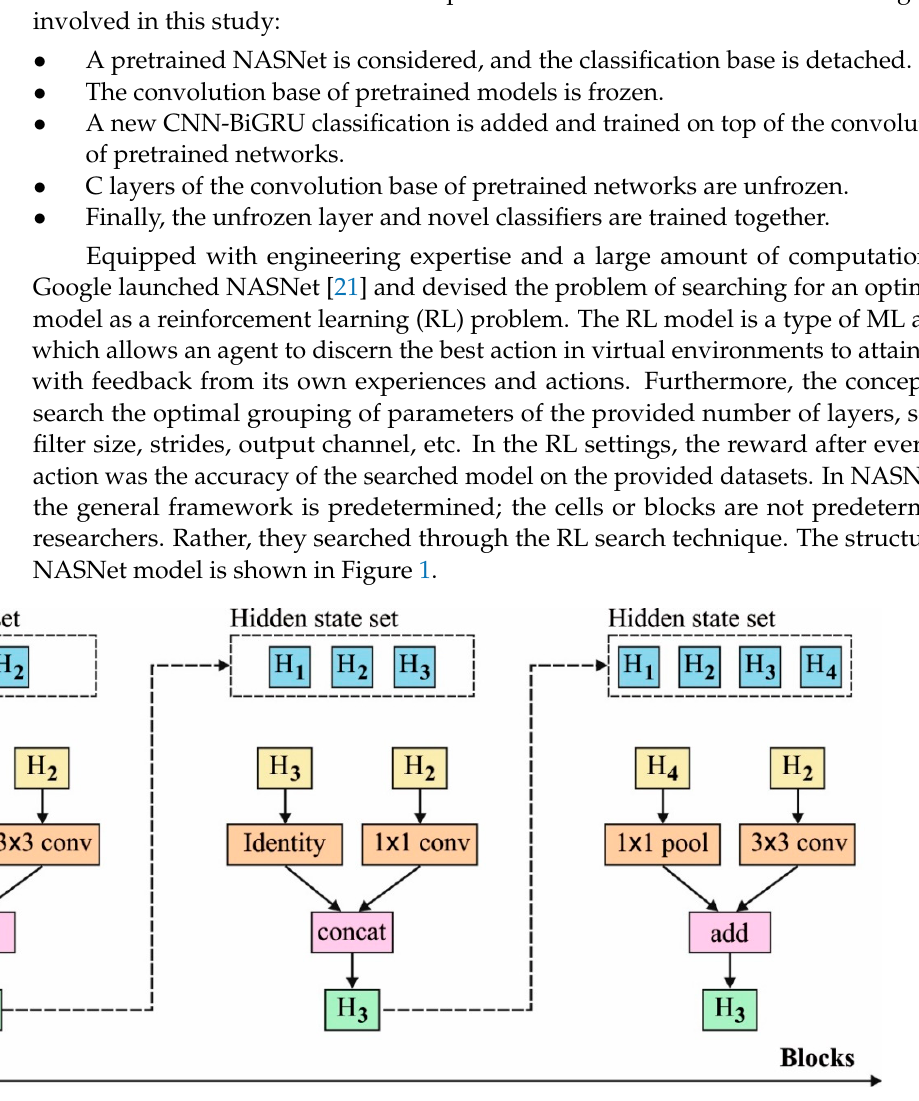
Figure 1. NASNet architecture.